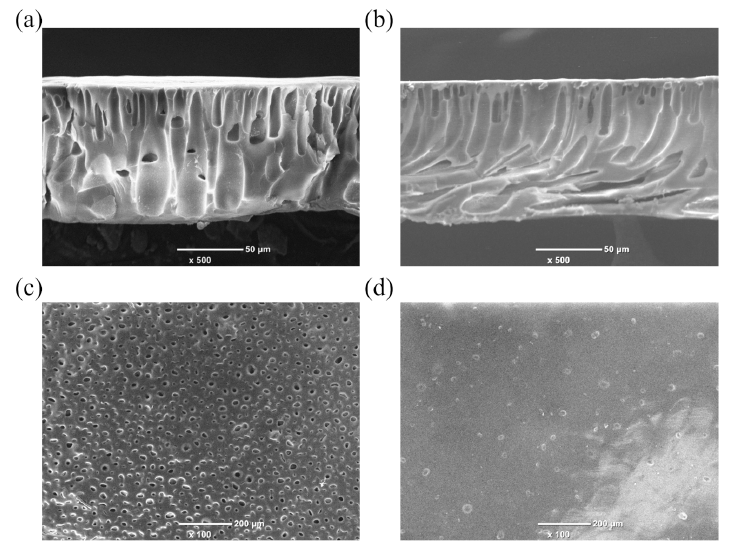
Figure 1. The ( a ) cross-section and ( c ) surface morphology of M0-300 membrane. The ( b ) cross-section and ( d ) surface morphology of M3-300 membrane. Table 1. Physicochemical properties of M0-300, M3-300 and Nafion membranes.